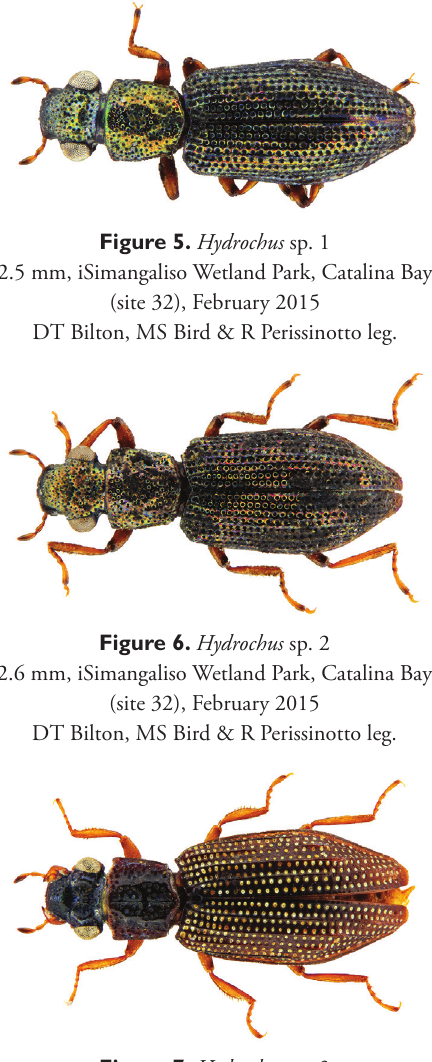
Figure 7. Hydrochus sp.